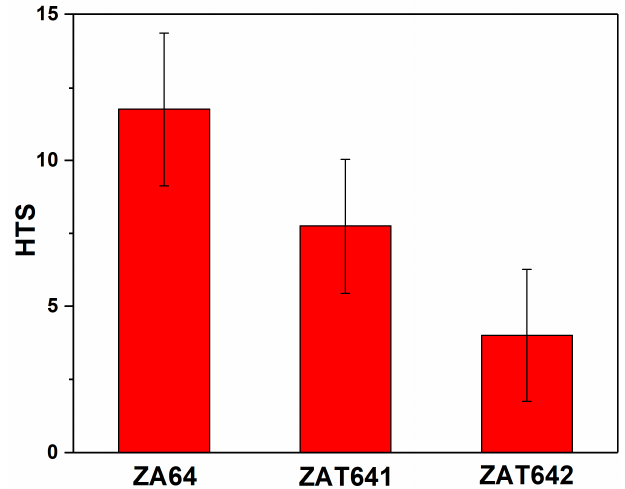
Figure 2. Hot tearing susceptibility (HTS) of die casting Mg-6Zn-4Al- x Sn alloys.